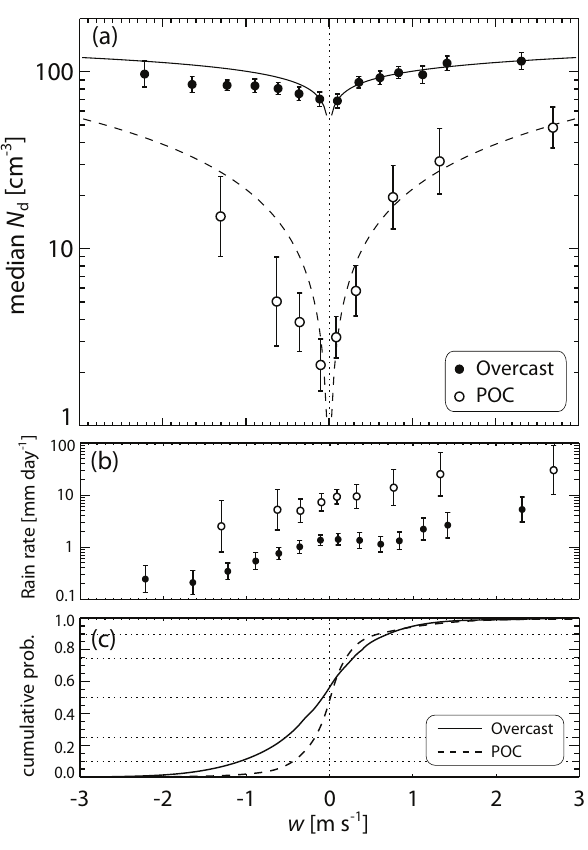
Fig. 19. (a) Median droplet concentration N d for RF06 cloudy samples (see Sect. 2.4) binned as a function of the sample’s vertical wind w magnitude in the overcast (solid circles) and POC (open circles) regions. Error bars show the approximate 95% confidence interval for the medians with degrees of freedom estimated using the approximately exponential decay of the autocorrelation function. Panel (b) : rain rate from the 2-D-C probe for cloudy samples binned as a function of w as in (a). Panel (c) : cumulative distribution function of the vertical wind from the cloud data in the overcast and POC regions.